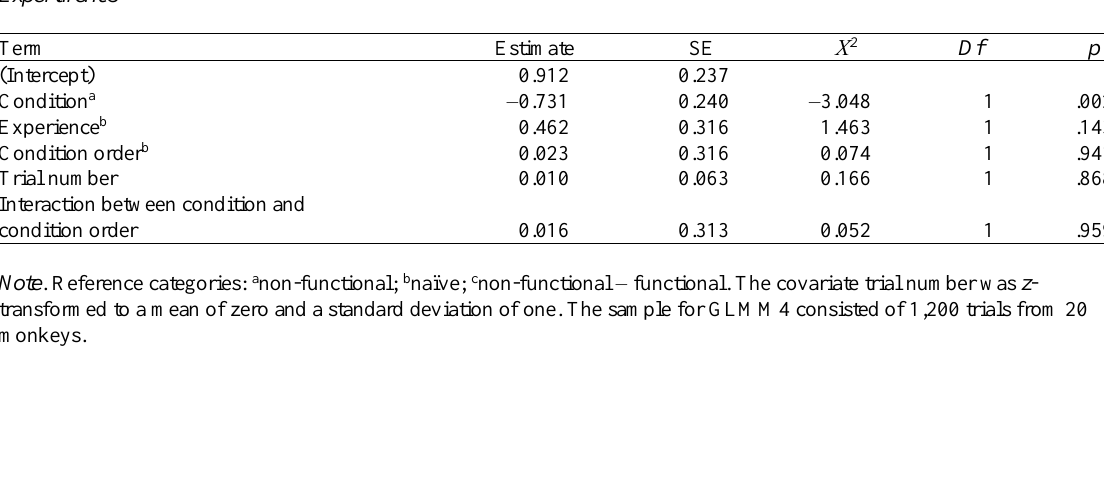
Glmm4: The Effect of Condition, Experience, and Condition Order on the Capuchin Monkeys Selecting the Correct Cup in Experiment